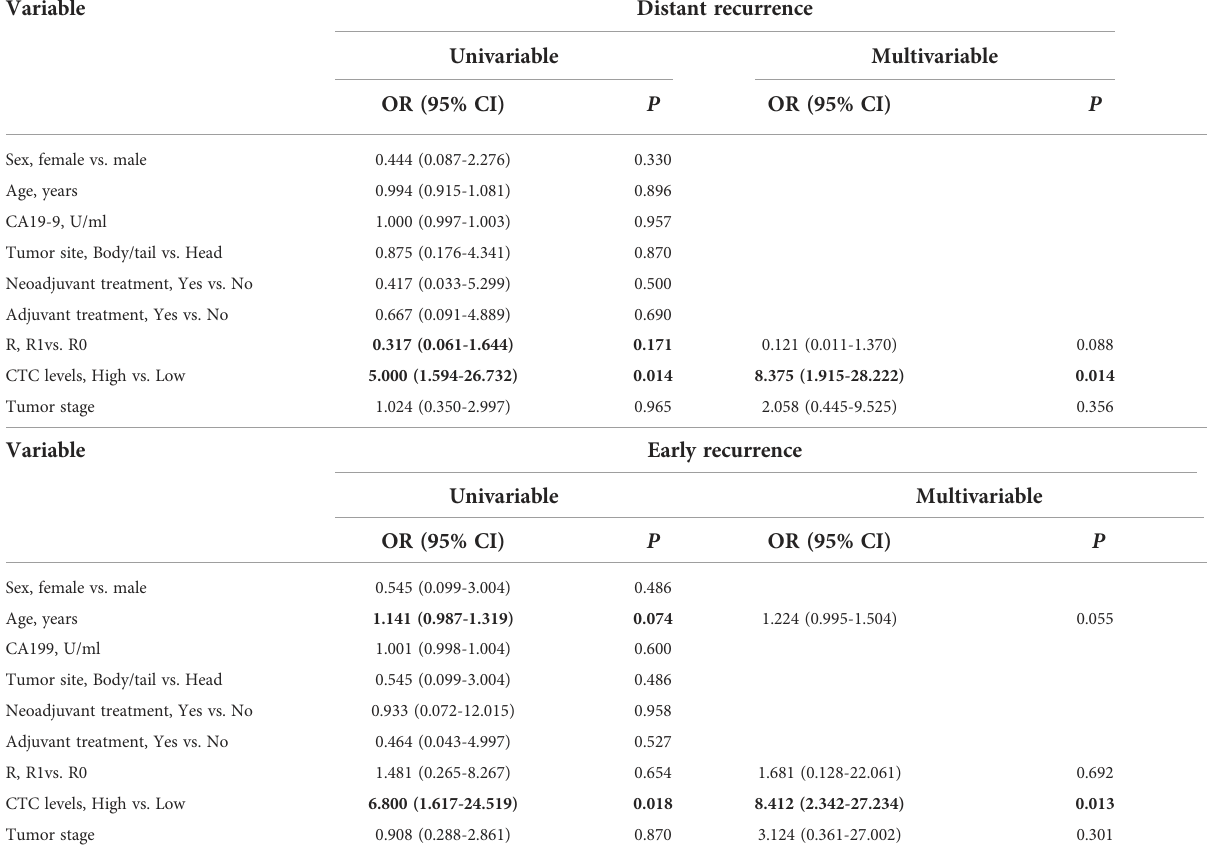
TABLE 5 Uni- and multivariable logistic regression analysis for risk factors in distant and early recurrence.